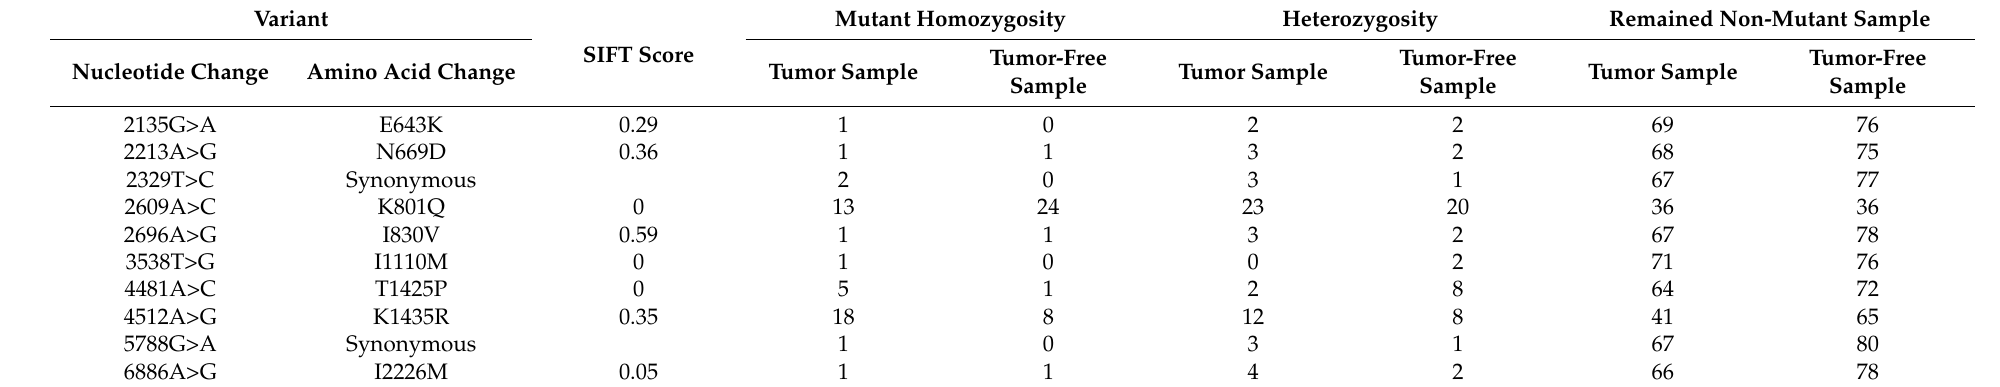
Table 1. Genotype frequencies and SIFT scores of mutations in tumor and tumor-free